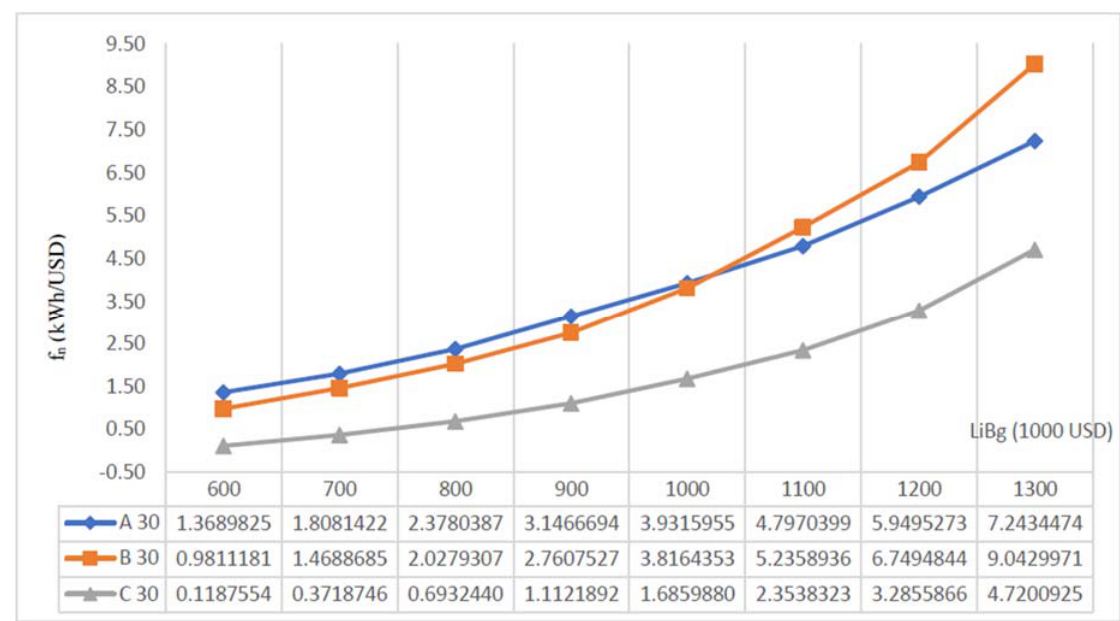
Figure 7. The ratio of renewable energy and life cycle cost with t = 30 years.